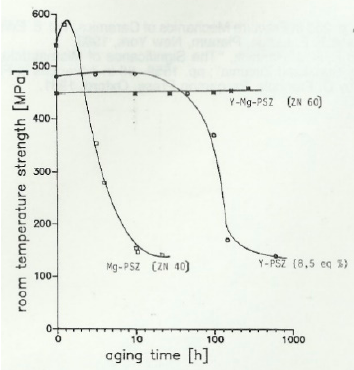
Figure 11. Thermal stability of Y-Mg-PSZ vs. Mg-PSZ.